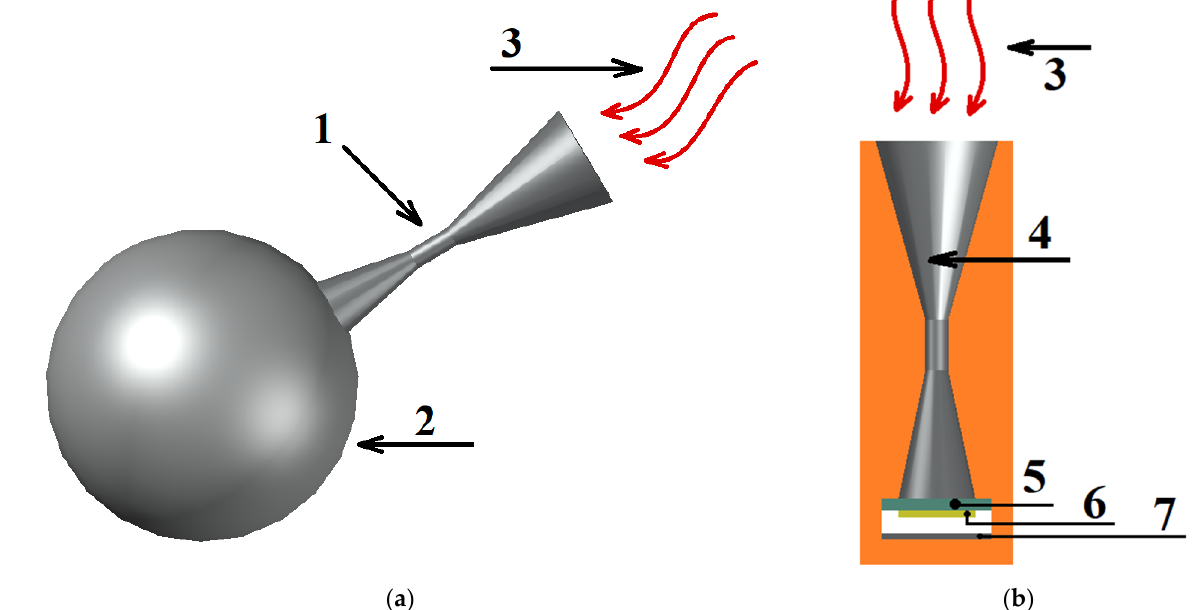
Figure 8. ( a ) Schematic view of matching horn device (1) with integrating cavity (2) of Planck space observatory surveyor satellite and (3) incoming radiation, and ( b ) our construction of back-to-back horn (4) and flat backshort (7) with array of annular planar antennas (6) with SINIS detectors on silicon substrate (5) (Reprinted with permission from Ref. [11]. Copyright 2020 Pleiades Publishing, Ltd.).